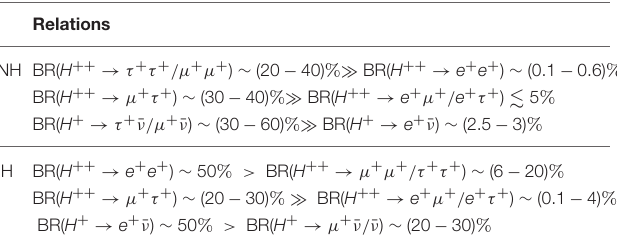
TABLE 2 | Relations among the branching fractions of the lepton number violating Higgs decays for the neutrino mass patterns of NH and IH, with vanishing Majorana